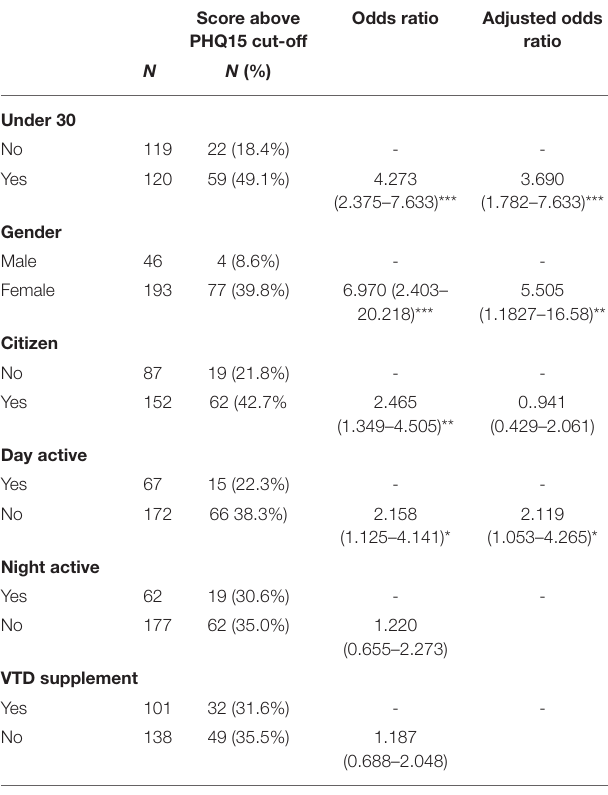
TABLE 5 | Bivariate and multivariate logistic regression predicting somatic symptoms. Score above PHQ15